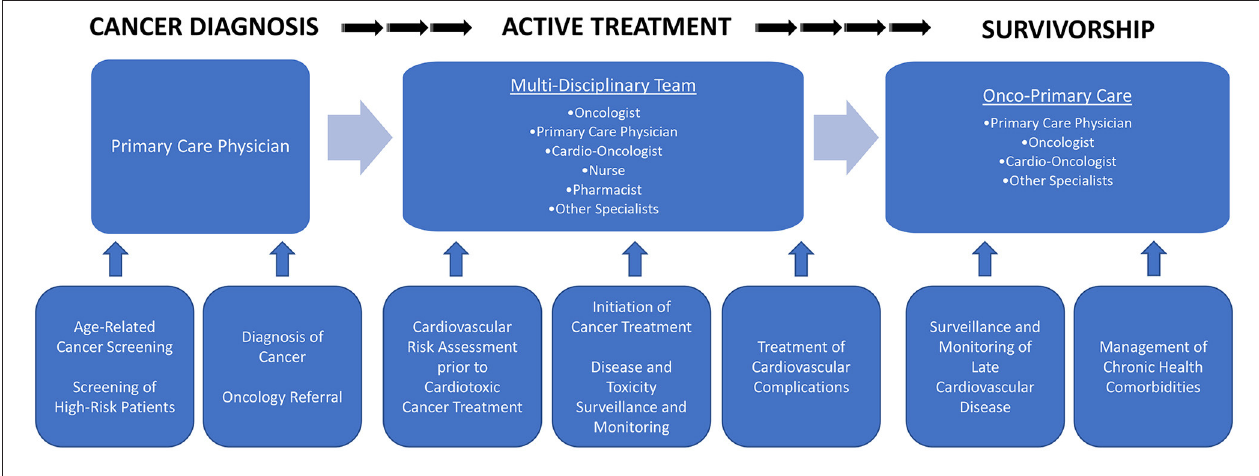
FIGURE 1 | The medical journey of cancer survivors.